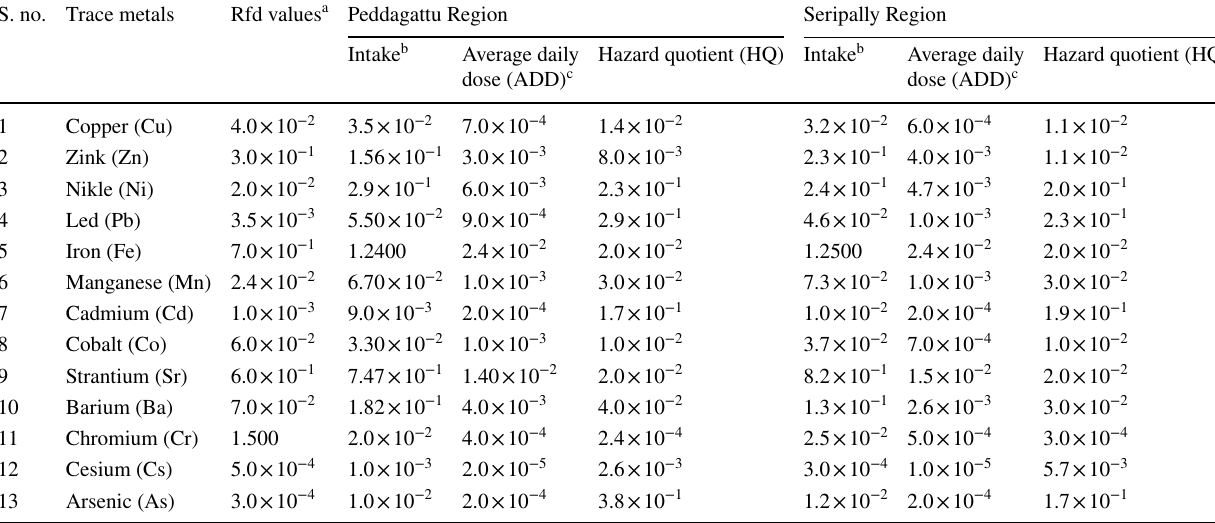
ADD in milligrams per kilogram body weight